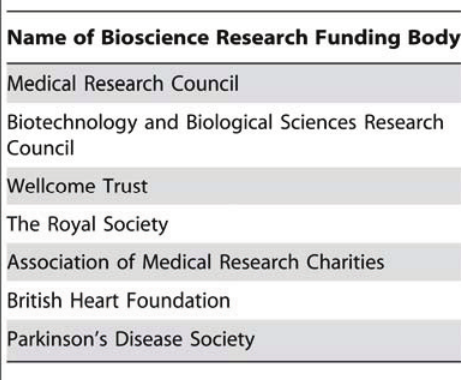
Table 1. Funding bodies